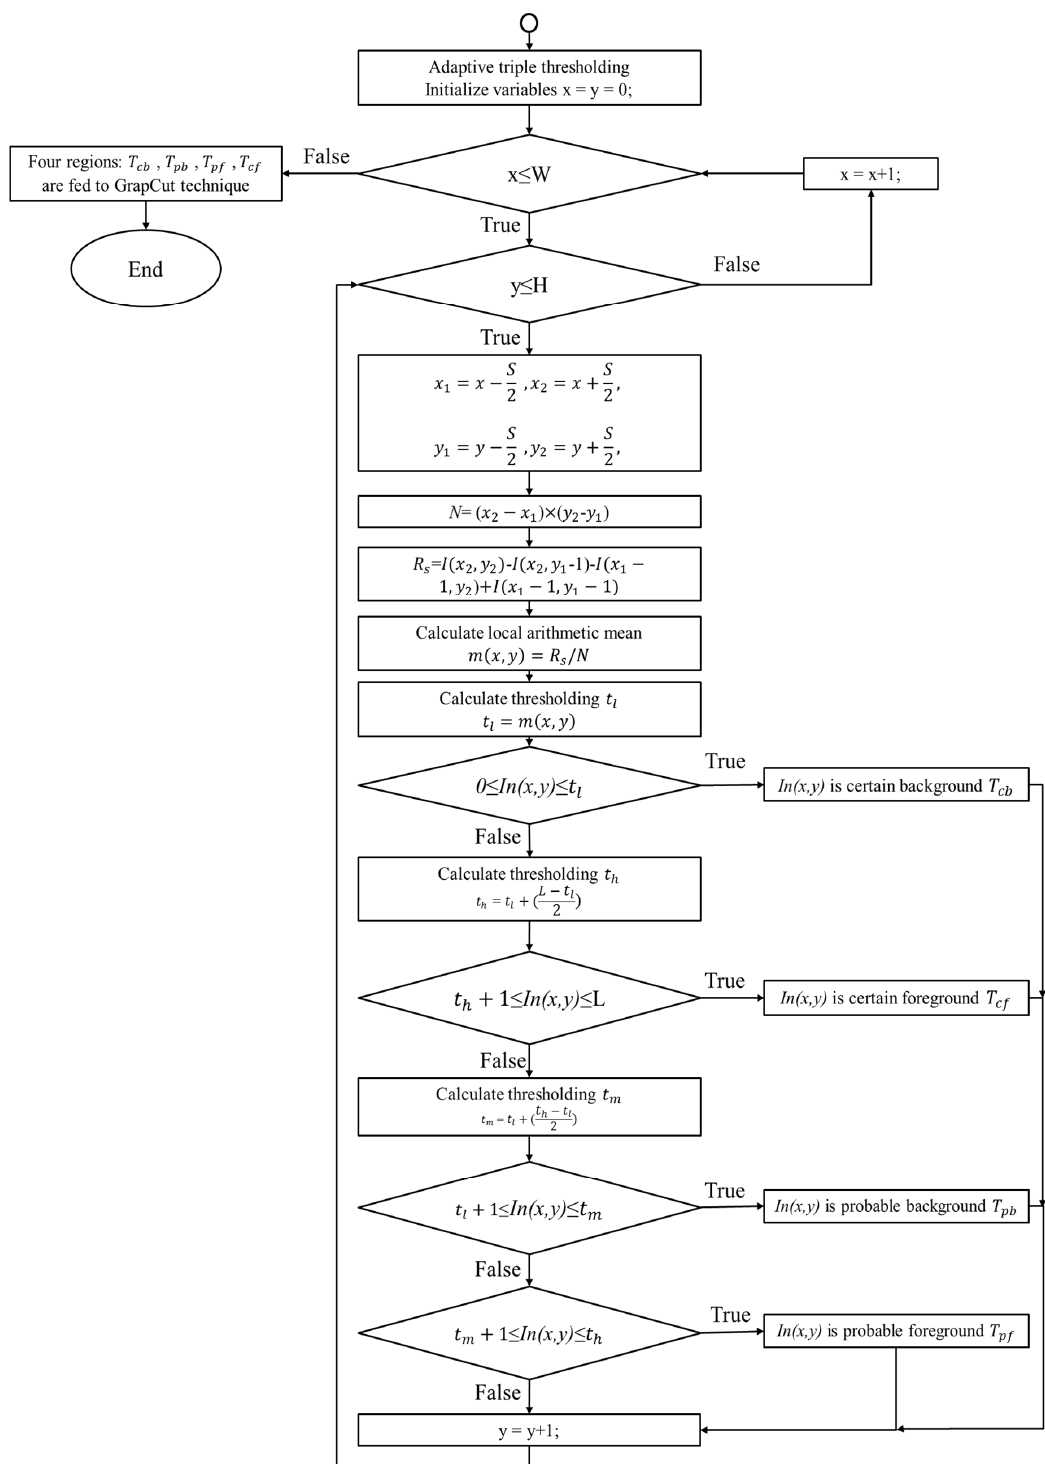
Figure A2. The block diagram of the proposed locally adaptive triple thresholding for salient object extraction (two-part).